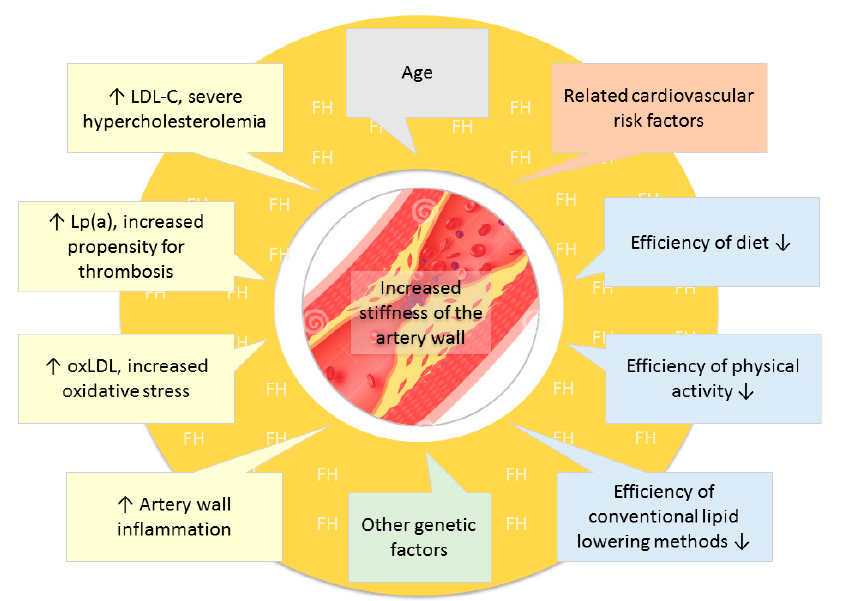
Figure 1. Factors leading to increased vascular stiffness in familial hypercholesterolemia. LDL-C: low density lipoprotein-cholesterol, Lp(a): lipoprotein (a); oxLDL: oxidized low-density